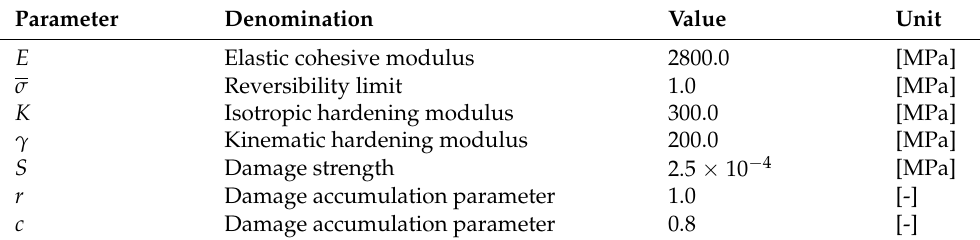
Table 2. Model parameters for concrete cohesive interface element.